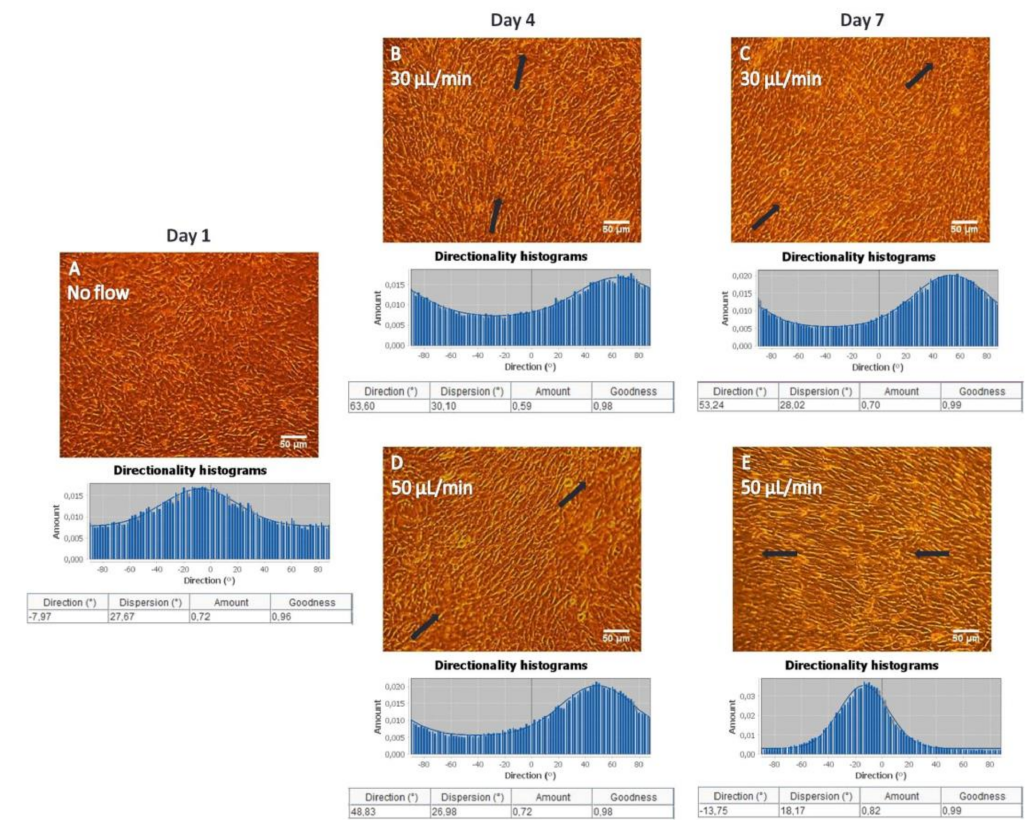
Figure 7. Morphology of MC3T3-E1 cells inside the flow perfusion culture system using fibrous collagen substrates under static conditions ( A ), and under flow conditions applying 30 ( B , C ), and 50 µ L/min ( D , E ) using optical microscopy (ten-fold magnification, the scale bar represents 50 µ m). The black arrows represent the direction of the flow. Directionality histograms and tables with the statistics generated by means of the Fiji ImageJ plug-in “Directionality” [25] are presented directly under the optical microscopy images ( A – E